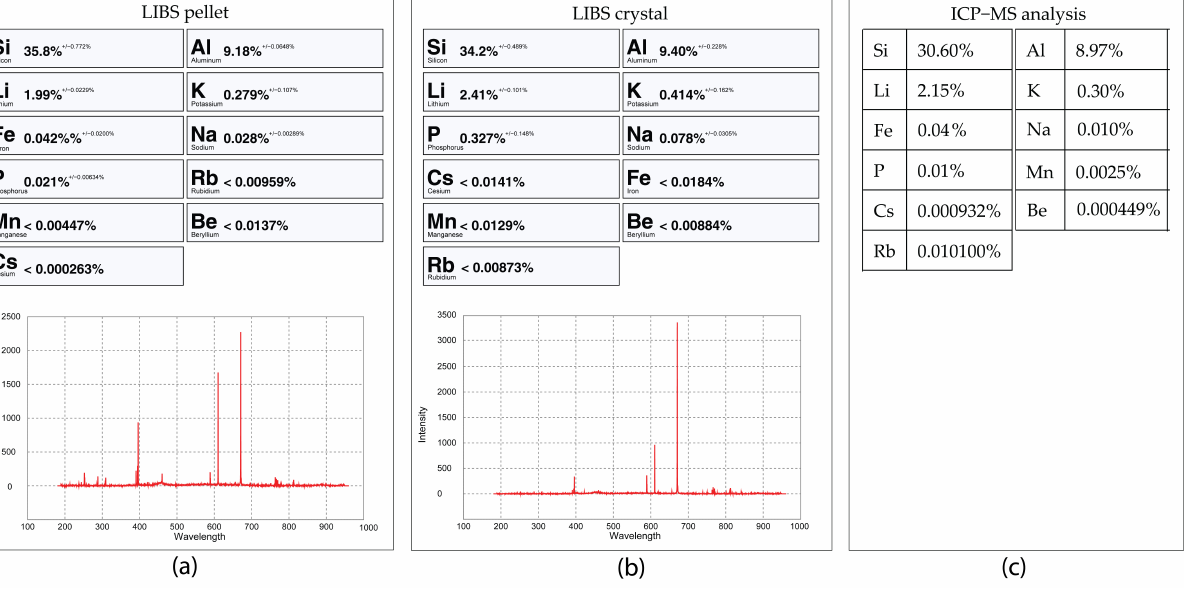
Figure 28. pLIBS analysis of the petalite sample 38-B1 in pellet ( a ) compared with the crystal sample ( b ) and the ICP-MS analysis ( c ). These LIBS analyses were performed with the Pet_Barroso